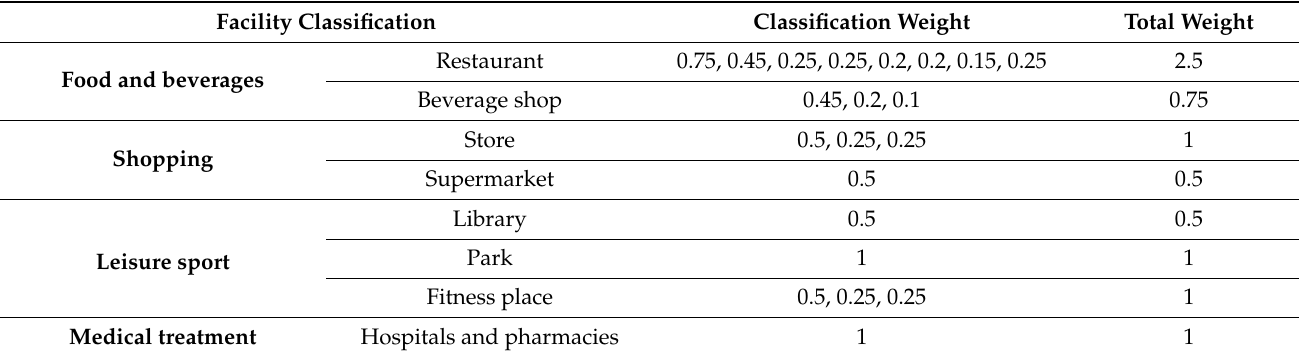
Table 2. Facility classification and weight